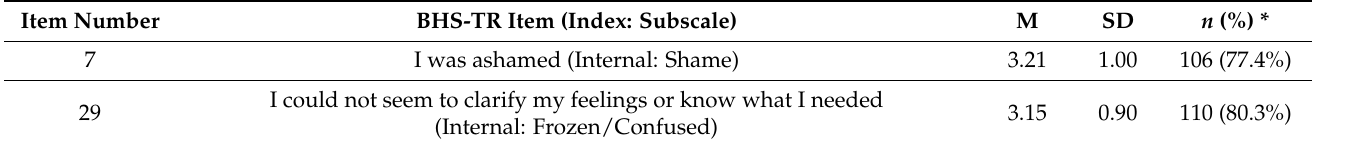
Table 4. Ranking of the items after influence ( n =